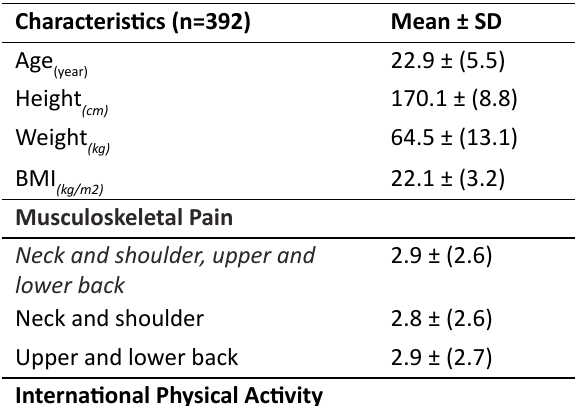
Table 1. Descriptive characteristics of university